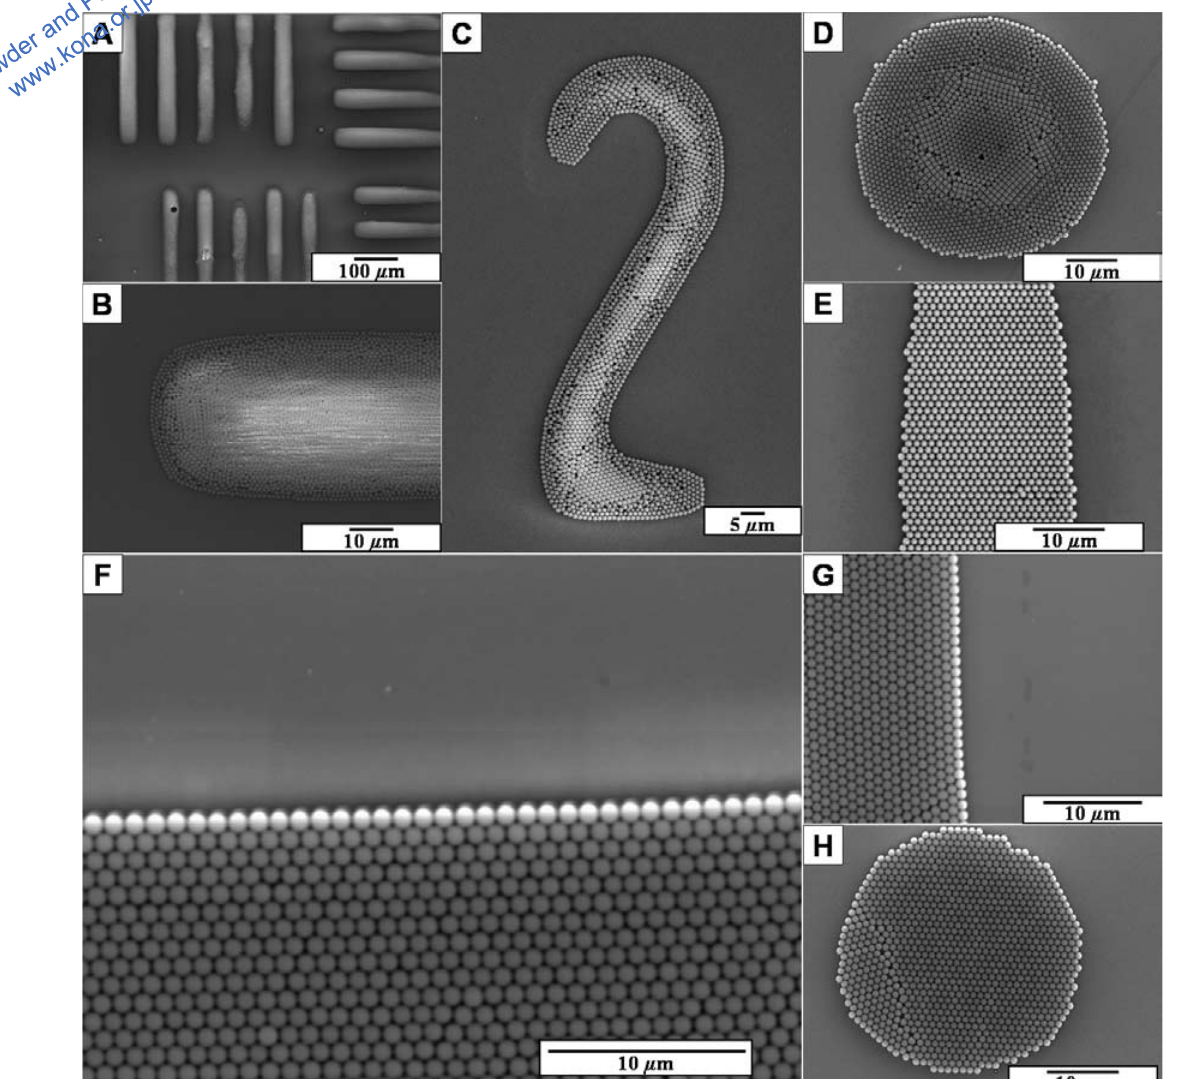
Fig. 2 SEM micrographs of patterned colloidal photonic crystals constructed from (A-B) multi particle-layers, (C-D) partially double particle- layers or (E-H) single particle-layers. Image (B) is a magnified area of